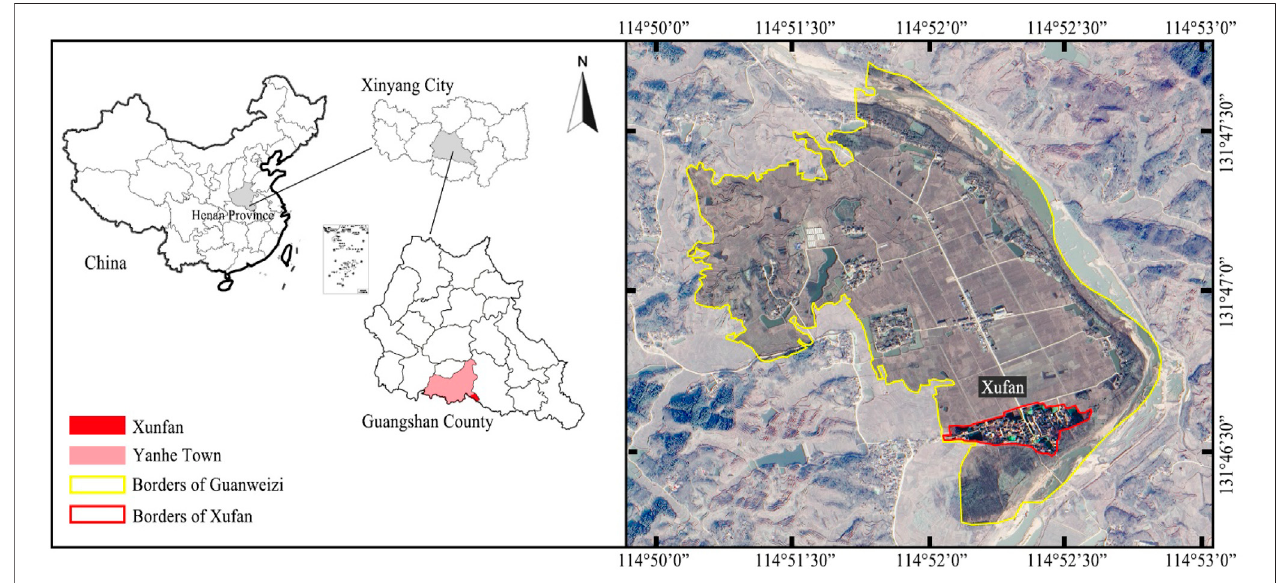
FIGURE 1 | Geographic location of the case study area.